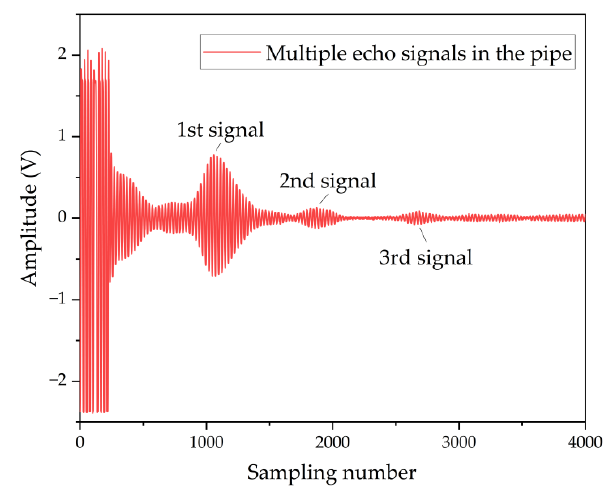
Figure 10. Multiple echo signals in the pipe.